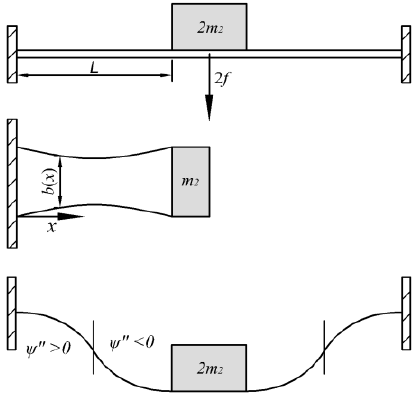
Figure 2. A double-clamped beam with a concentrated proof mass.